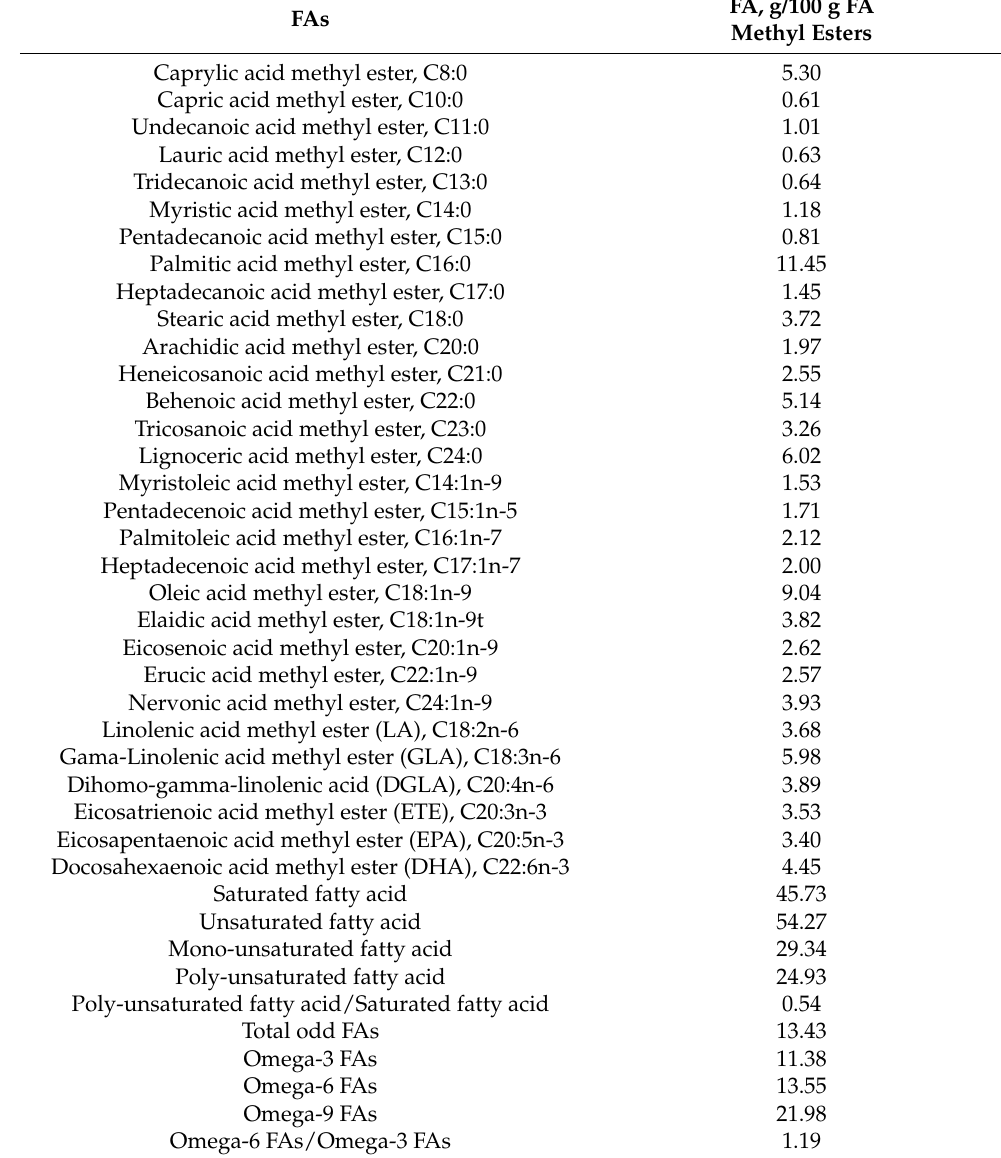
Table 1. Fatty acids (FAs) profile and encapsulation efficiency of each individual identified FA of nano-encapsulated Moringa leaves ethanolic extract